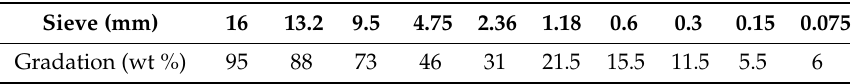
Table 3. The gradation of